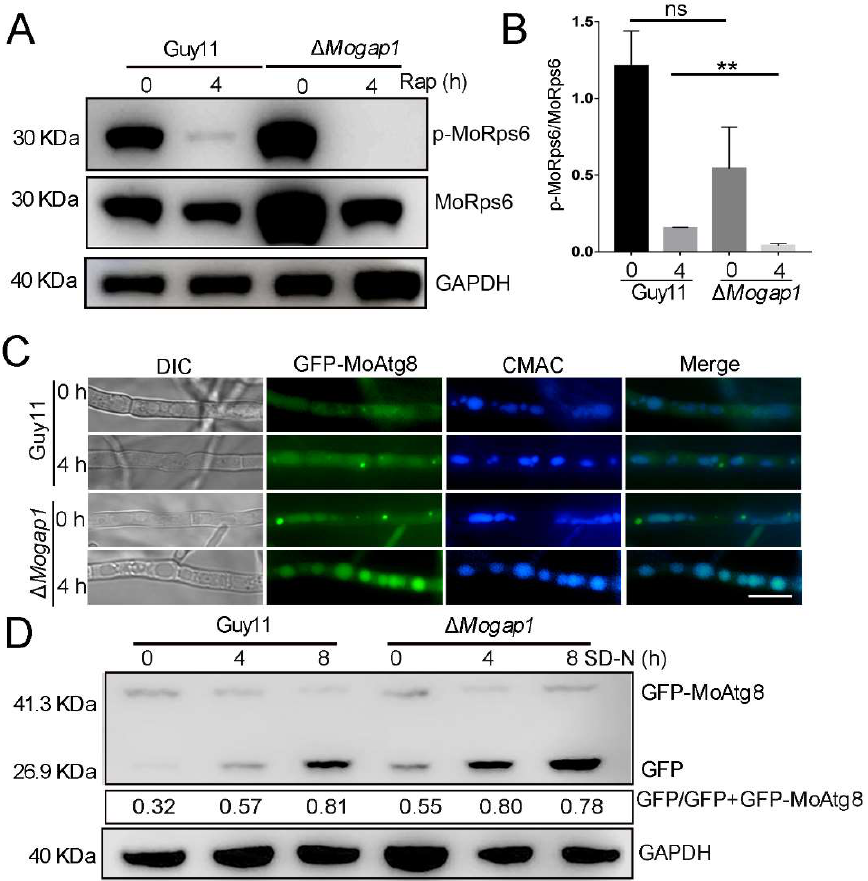
Figure 4. MoGap1 negatively regulates autophagy. ( A ) MoRps6 phosphorylation levels of Guy11 and ∆ Mogap1 after 0 h and 4 h of 30 ng/mL rapamycin induction with GAPDH as internal reference. ( B ) The phosphorylation levels of MoRps6 were calculated and graphed using Prism 7.0 software ( t -test; ns: no significant, ** p < 0.01). ( C ) Autophagy flux was observed in the wild-type Guy11 and ∆ Mogap1 strain in CM and starvation conditions. Bar = 10 µ m. ( D ) Expression levels of GFP-MoAtg8 and GFP in Guy11 and ∆ Mogap1 , respectively, after SD-N starvation with GAPDH as internal reference.